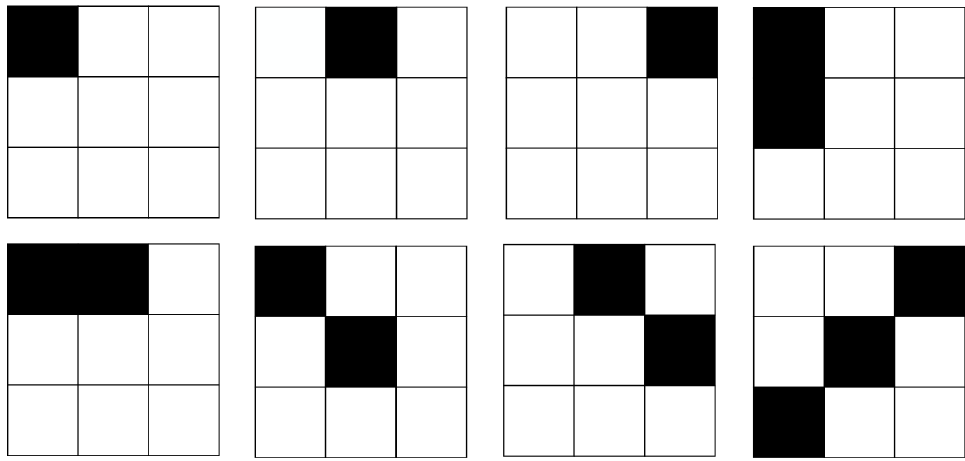
Figure 4. Examples of candidate labels generated based on spatial attention